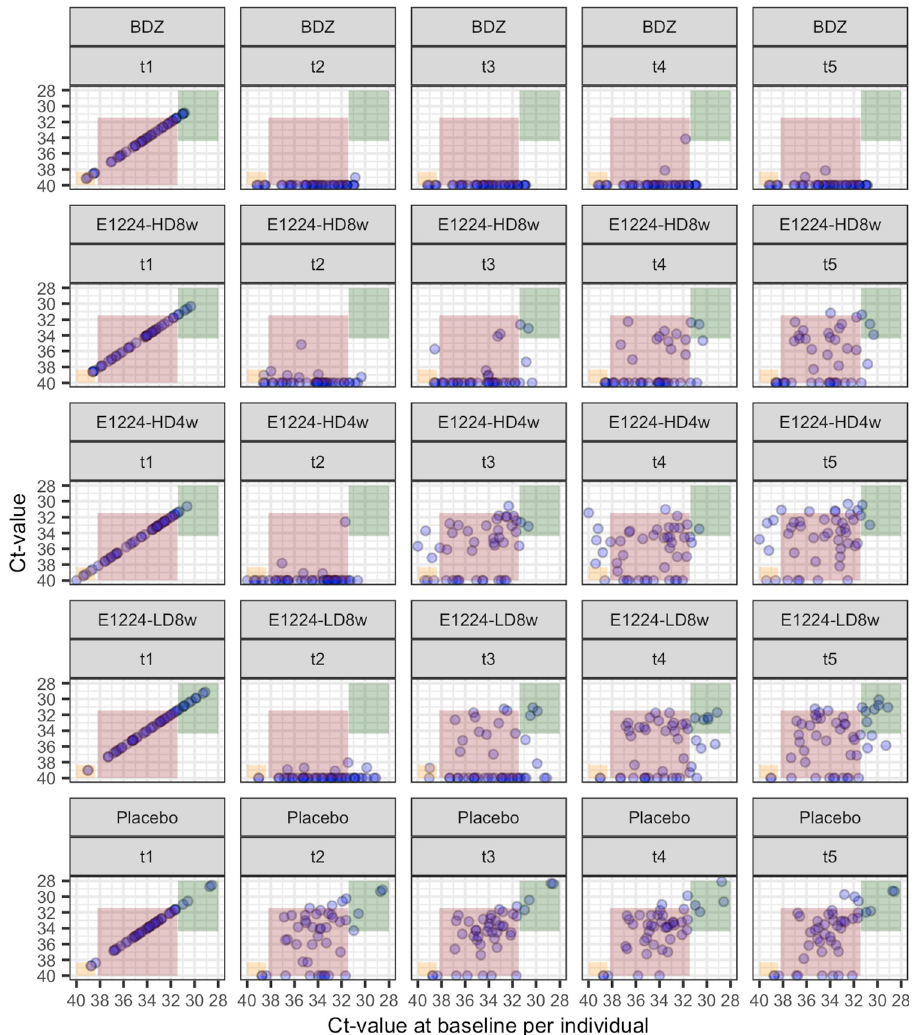
arm and time point at each panel. The x-axis represents the individual Ct-value at baseline, and the y-axis represents the individual Ct-value at each time point assessed. Colored areas represent the expected Ct-value range under the no treatment counterfactual for BDZ, E1224-HD8w, E1224-HD4w, E1224-LD8w and placebo, at time-points t0-t4, representing baseline, 2, 4, 6, and 12 months respectively. Colored areas represent predicted counterfactual Ct-values range for a) individuals with alternating detectable/undetectable parasitemia with at least one value under threshold 2 (orange); b) individuals with alternating detectable/undetectable parasitemia with any value over threshold 2 (red); and c) individuals with continuous detectable parasitemia with at least one value over threshold 1